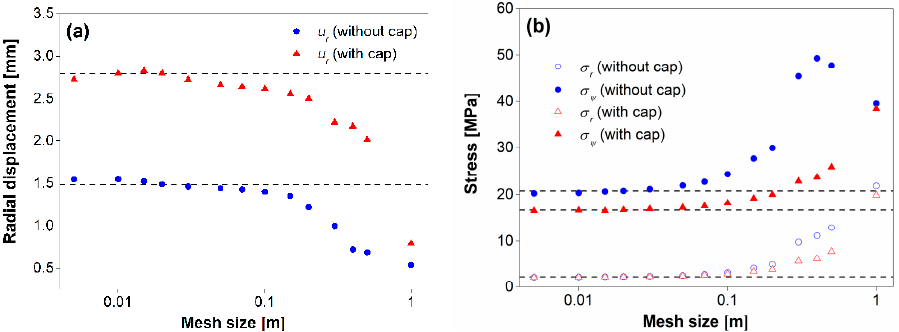
Figure 4. Variation of the ( a ) radial displacements and ( b ) stresses at point M (see Figure 3b) as a function of the mesh size (with d = 10 m), obtained from the MSDP u ‐ EPP model with and without the cap.